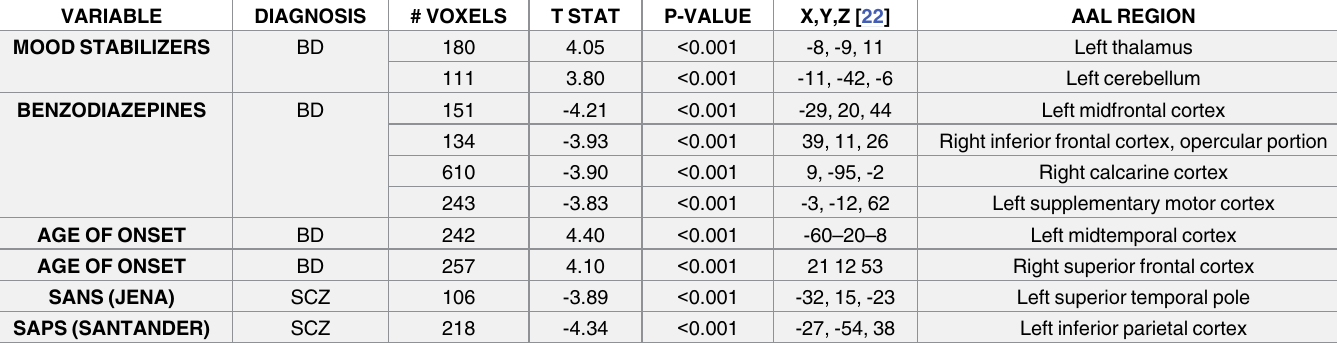
BD: bipolar disorder. SCZ: schizophrenia. AAL: Automated Anatomical Labeling. SANS: Scale for Assessment of Negative Symptoms. SAPS: Scale for Assessment of Positive